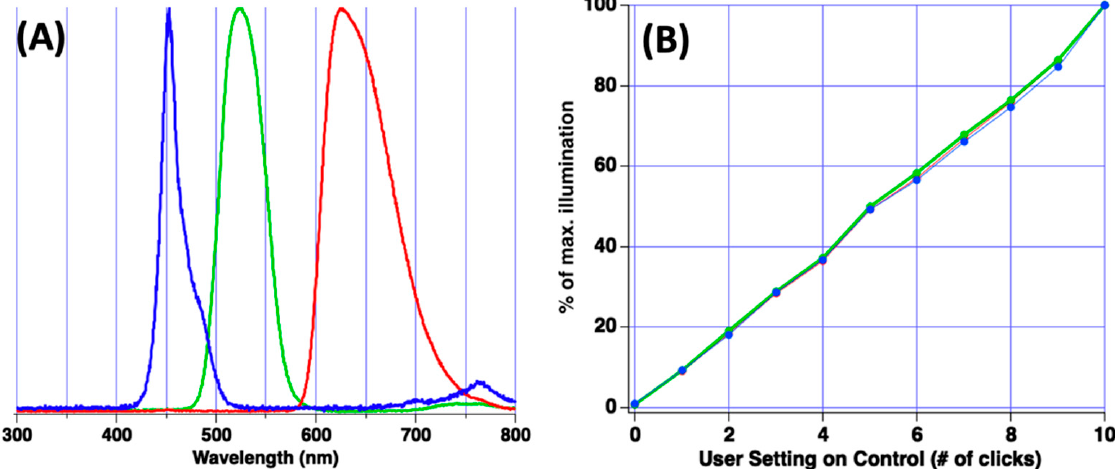
Figure 3. ( A ) Plot of illumination spectra from the LED panel when using the blue, green and red filter. ( B ) Plot of fraction of maximal illumination vs. intensity setting set by end-user.